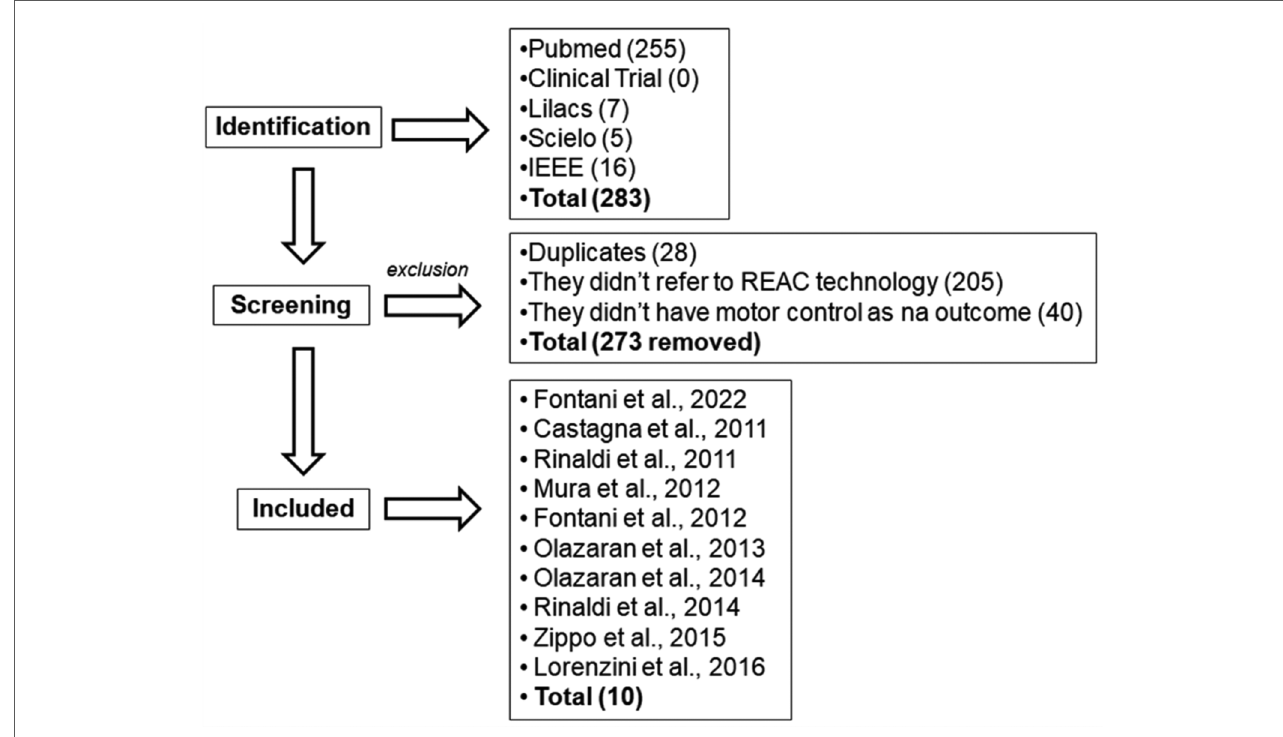
FIGURE 1 Flowchart of the identi fi cation, screening, analysis and inclusion of studies in the review